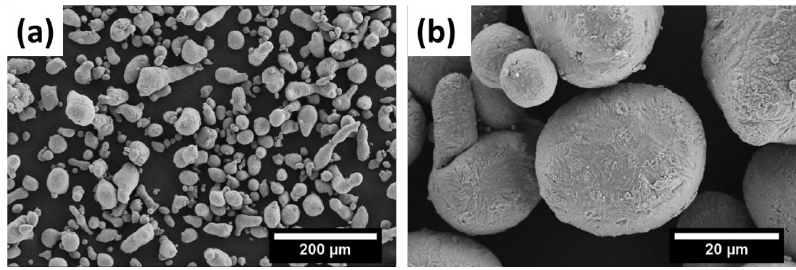
Figure 1. Field Emission Scanning Electron Microscope micrographs of A357 gas atomized particles. Table 1. Nominal chemical composition of A357 and A356.